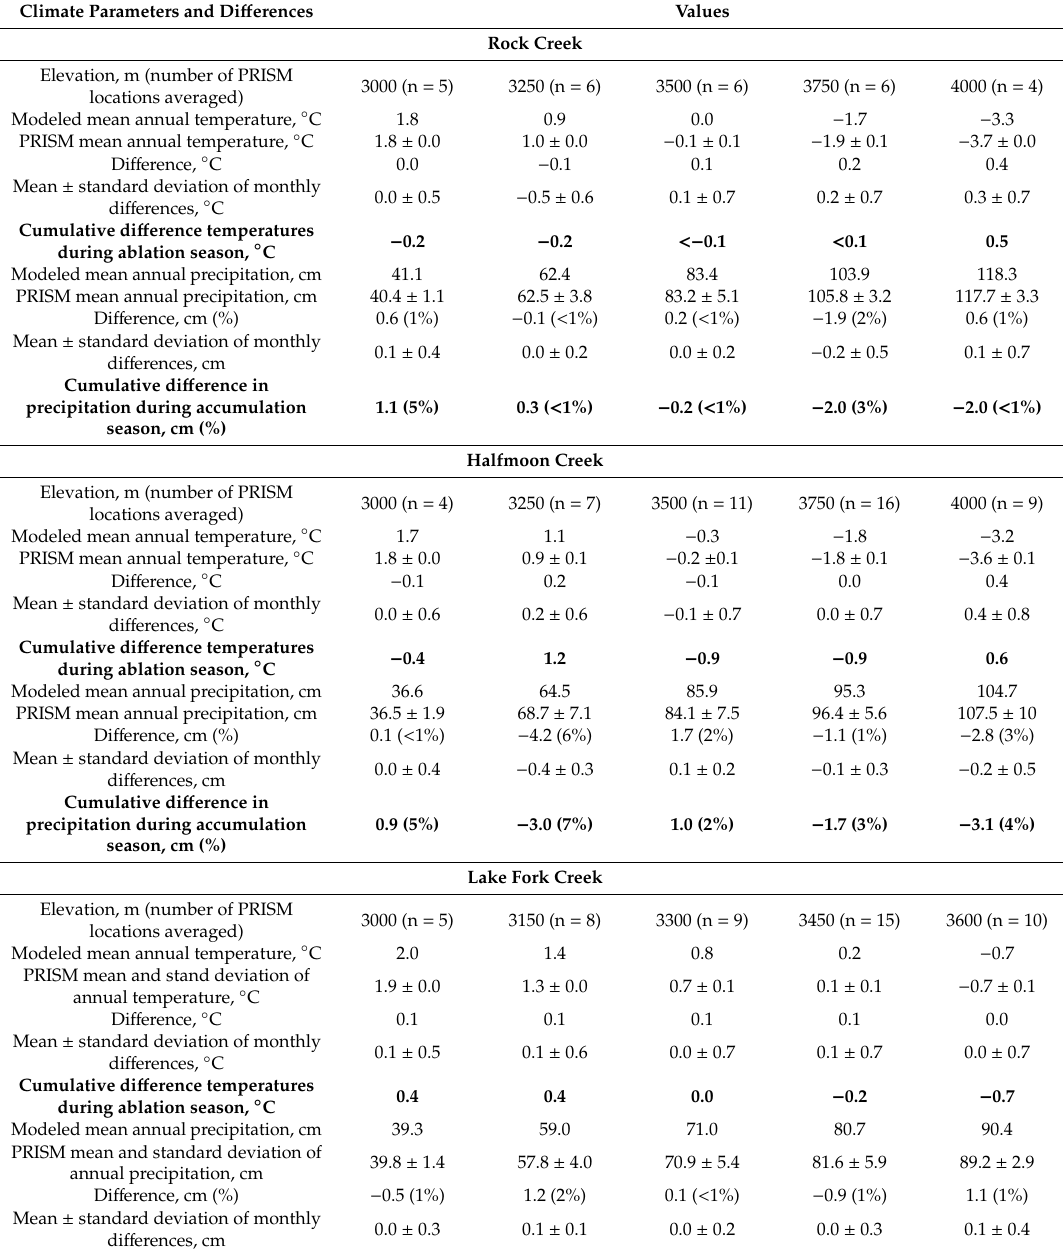
Table 3. Comparison of modeled modern temperature and precipitation with PRISM values at select elevations in the study area. Percentages are rounded to the nearest whole number or noted when less than one percent. Elevation ranges shown account for ≥ 90% of glacier areas. Values in bold are most significant in terms of modeling paleoglacier mass